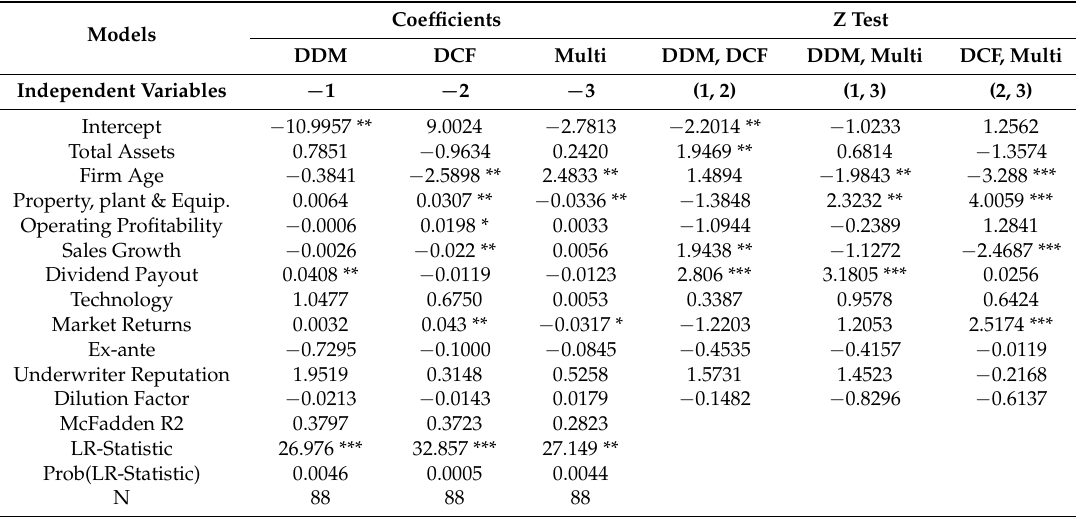
Table 6. The Equality of Coefficients from Different Valuation Models’ Test